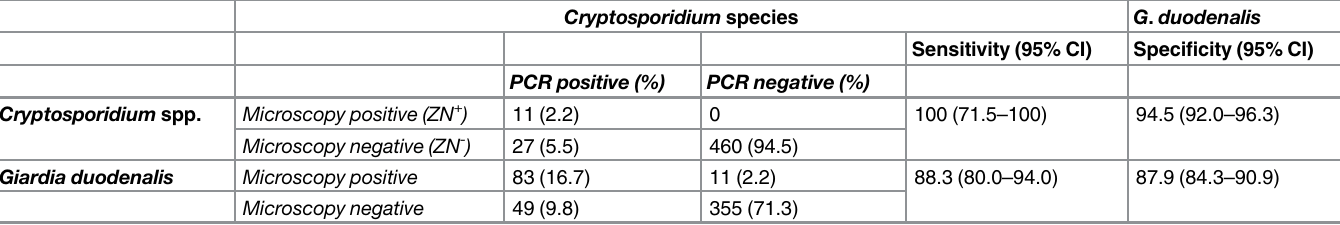
Table 1. Detection of Cryptosporidium spp. and Giardia duodenalis